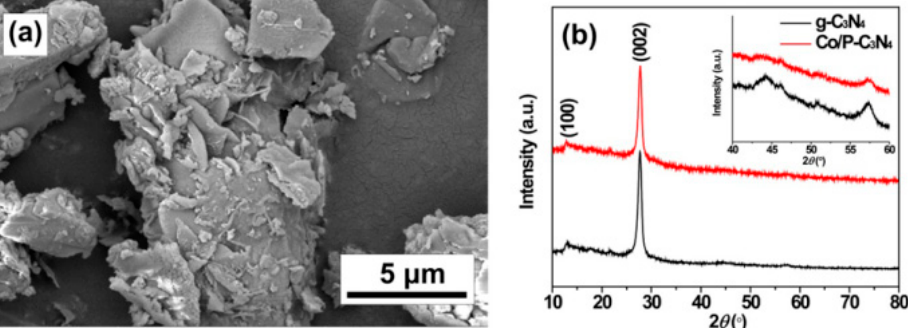
/ P-C 3 N 4 , and ( b ) XRD patterns of g-C 3 N 4 and Co